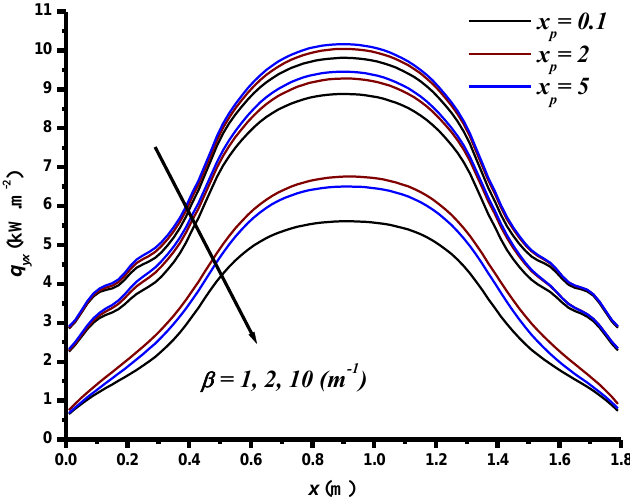
Figure 13. Evolution of the y -net radiation heat flux density component along ( x , 1.8, 0.6) m vs the fly ash particle size parameter ( ω = 0.5 ).